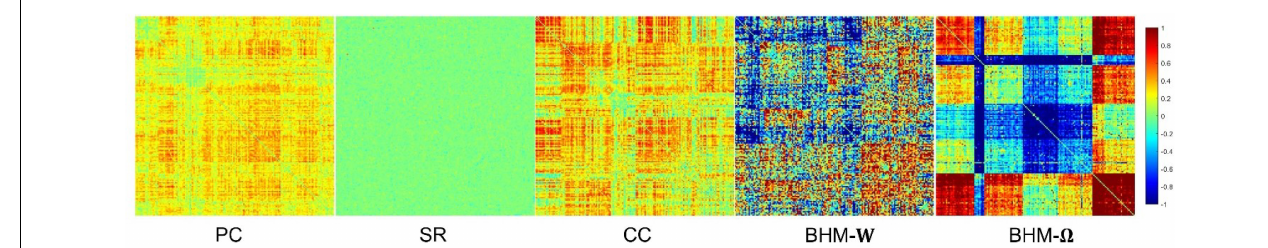
FIGURE 3 | Five clustered edge weight matrices of the same subject estimated by different methods.